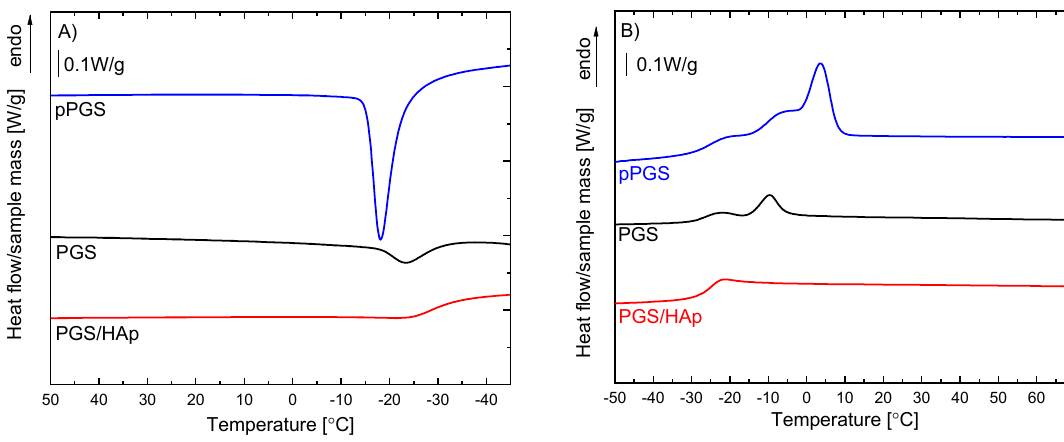
Figure 8. The cooling ( A ) and second heating ( B ) DSC curves of prepolymer pPGS and porous scaffolds PGS and